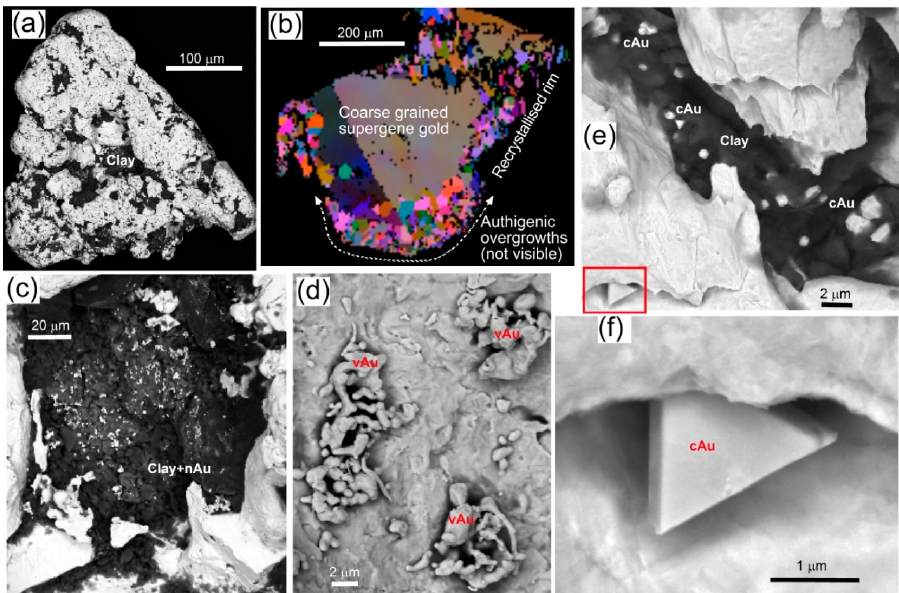
Figure 8. SEM images of detrital gold from Late Pleistocene gravels of the Patearoa area (Figures 1a,b and 3a,c). ( a ) Electron backscatter image of exterior surface of a detrital particle; ( b ) Electron backscatter diffraction image (Euler colours) of a polished section etched with aqua regia , showing the coarse grained internal structure derived from supergene source, and a rim of finer grained gold recrystallised after transport-induced deformation. Authigenic overgrowths (not visible in ( b ); as in ( c – f ) coat the rims; ( c – f ) Electron backscatter images of authigenic gold overgrowth textures (nAu = nanoparticulate; vAu = vermiform; cAu = crystalline).